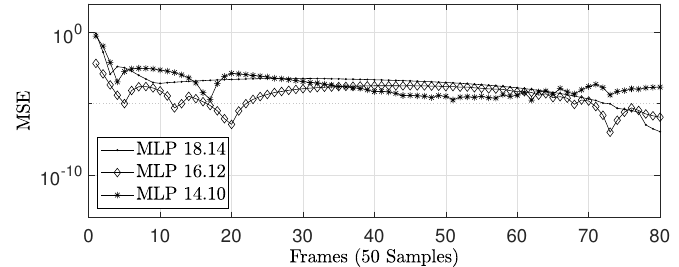
Figure 35. Comparison of the MSE value between MLP-BP